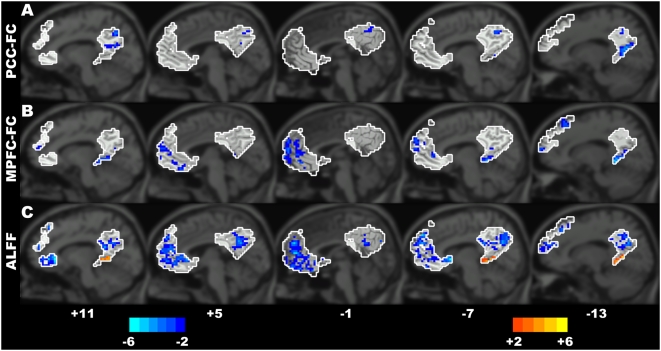
The differences in the PCC-FC maps (A), the MPFC-FC maps (B), and the ALFF maps (C) between the first EC condition and the second EC condition (First EC - Second EC) within the DMN.The areas in the white contours denote the ROIs within the DMN. The numbers below the images refer to the x coordinates in the Talairach and Tournoux atlas. The statistical threshold was set at |t|>2.093 (P<0.05) and cluster size >486 mm3, which corresponds to a corrected P<0.05.